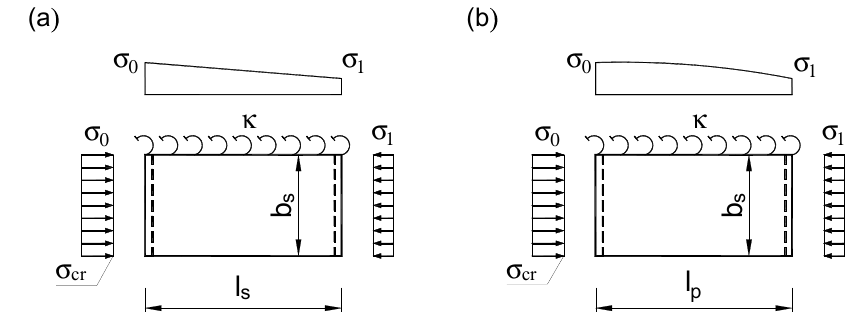
Figure 3. Longitudinal stress distribution in a cantilever plate: ( a ) linear, ( b ) non-linear according to 2° parabola.